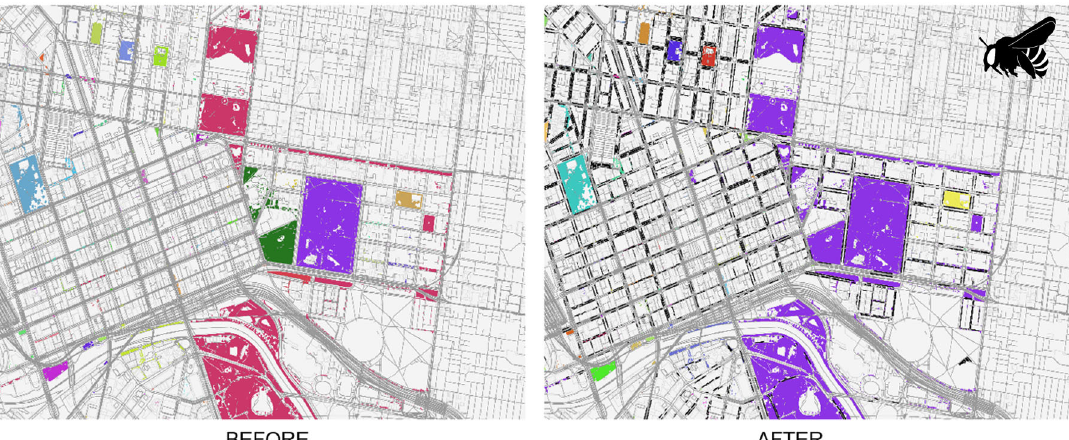
Fig. 3 Ecological connectivity improvements for the blue-banded bee ( Amegilla spp .) in Melbourne, showing how fragmented habitat patches (coloured differently) become more connected within the landscape (coloured the same). This effect was much more marked in scenarios where parking spaces were moved 200 m instead of 100 m. Supplementary Tables 1, 2 supplies detailed connectivity values recorded for each parking scenario, along with the corresponding mean connected area size and number in relation to the total area of habitat available in each scenario.